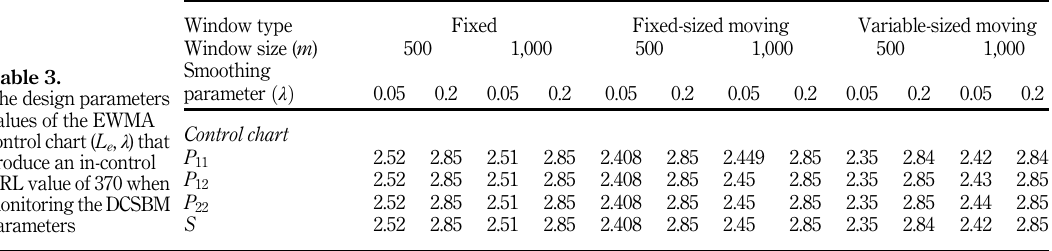
Table 3. The design parameters values of the EWMA control chart ( L e , λ ) that produce an in-control ARL value of 370 when monitoringtheDCSBM